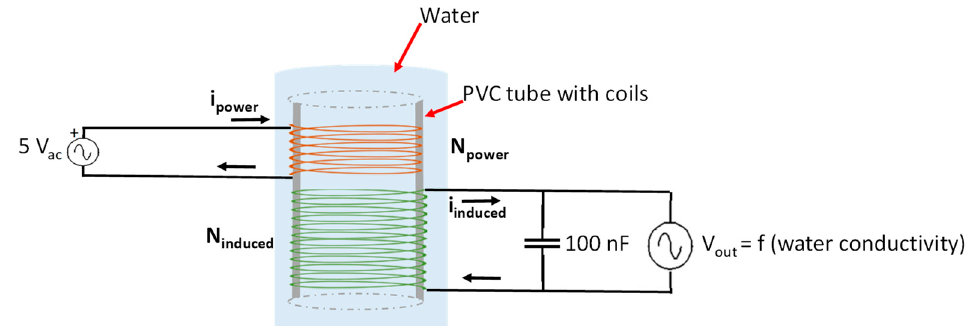
Figure 2. Diagram of the testbench.